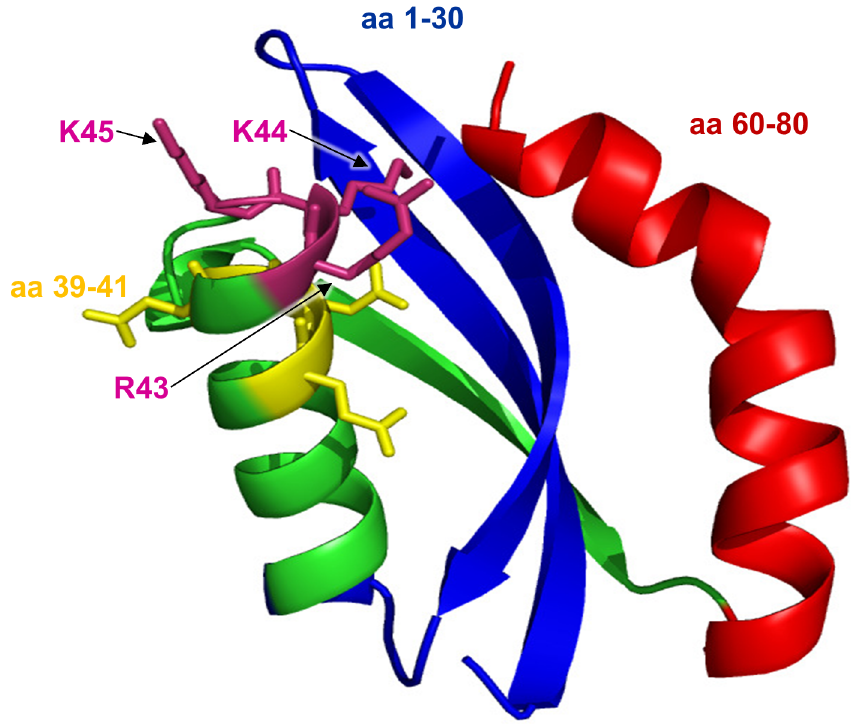
Fig 6. Predicted 3D structure of N . meningitidis PilG residues 1 to 80. The N . meningitidis MC58 PilG hypothetical structure generated by the SAM-T06 modeling server is shown in cartoon form with the residues 1 to 30 colored blue and 60 to 80 colored in red, illustrating that these two regions in the folded form are predicted to be closely located. The lysine and arginine residues 43 to 45, which are conserved in Neisseria and showed a role in DNA binding, possibly due to their positive charge, are labelled. In addition, the position of the PilG alanine substitution of mutant PilG EEE39-41AAA is indicated in